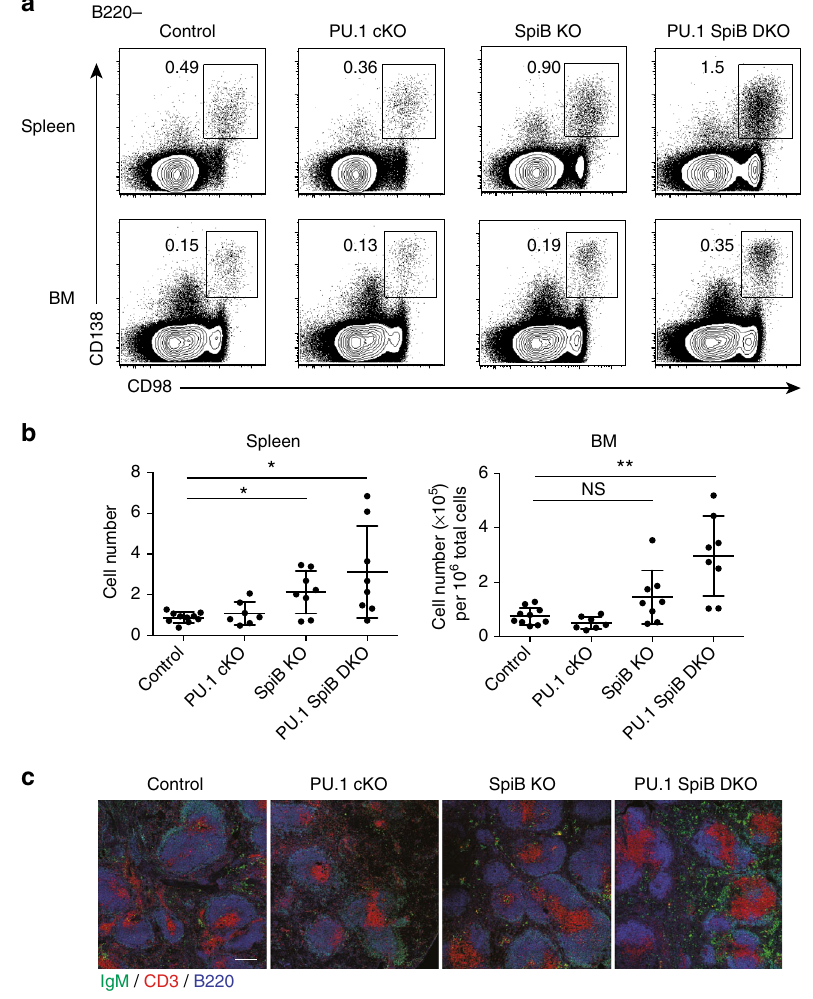
Fig. 2 Increased plasma cell frequency in PU.1 SpiB DKO mice. a Flow cytometric analysis of splenocytes and bone marrow from mice of the indicated genotype for the detection of plasma cells (B220 − CD138 + CD98 + ). Data are representative of 7 – 10 mice per genotype. The full gating strategy is shown in Supplementary Fig. 8B. b Absolute numbers (for spleen) and proportion (for bone marrow) of plasma cells are graphed as the mean ± s.d. P -values compare the indicated samples (two tailed t -test). Each circle represents the results from an individual mouse. * P < 0.05, ** P < 0.01. c Immuno fl uorescence of spleen sections of each of the four genotypes stained for T cells (CD3, red), B cells (B220, blue) and antibody-secreting cells (IgM high , green). Scale bar = 200 μ